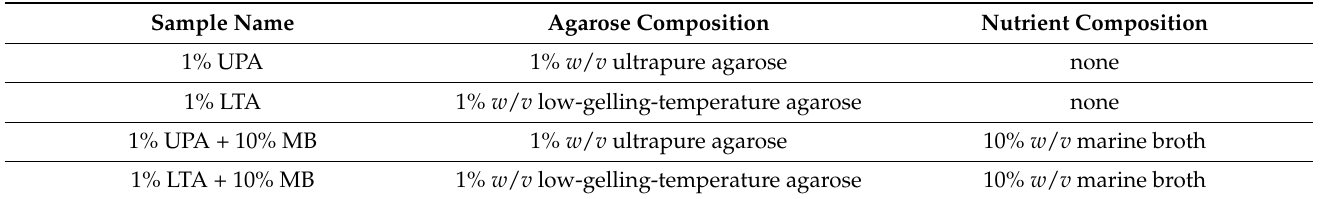
Table 2. Composition of